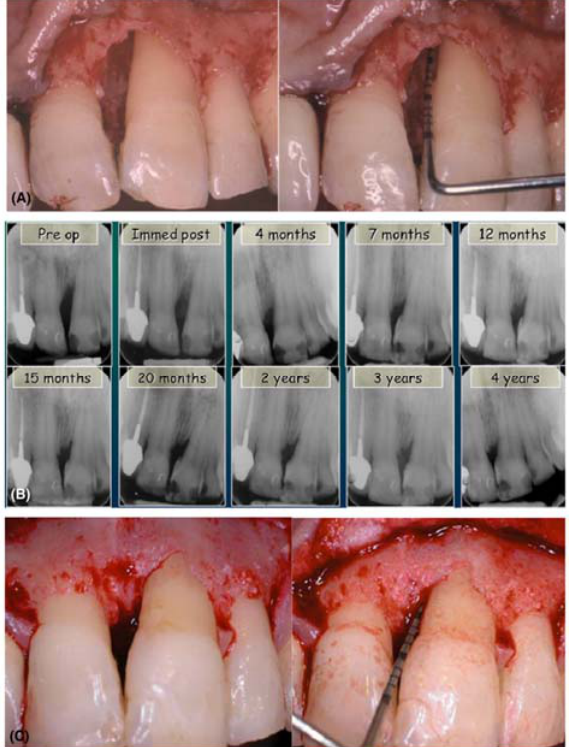
Figure 5. ( A ) Pre-operative clinical images showing a deep intrabony defect, ( B ) X-rays depicting appreciable defect fill following treatment with EMD in combination with a bone graft, and ( C ) four year outcome following intrabony defect repairment with EMD. Reprinted from [140] with permission from Wiley Online.